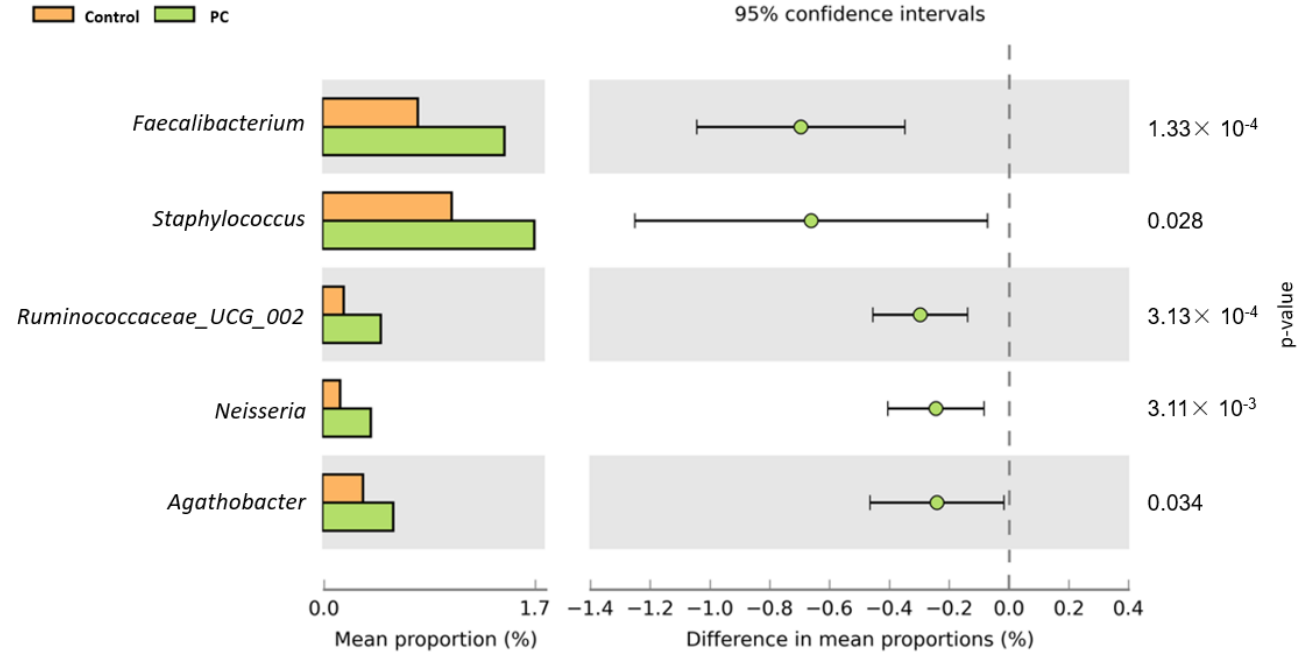
Figure 7. Urine sample microorganism genus relative abundance—PC vs. Control. Left side of the figure shows mean abundance proportion. Right side shows difference in mean abundance proportions 95% confidence interval.